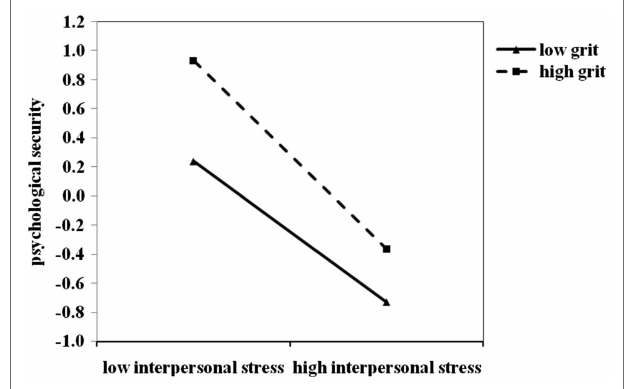
FIGURE 2 | The moderating role of grit on the relationship between Interpersonal stress and Psychological security in Study 2. All the study variables were standardized. High/low level of Interpersonal stress = M ± 1SD. High/low level of grit = M ± 1SD.